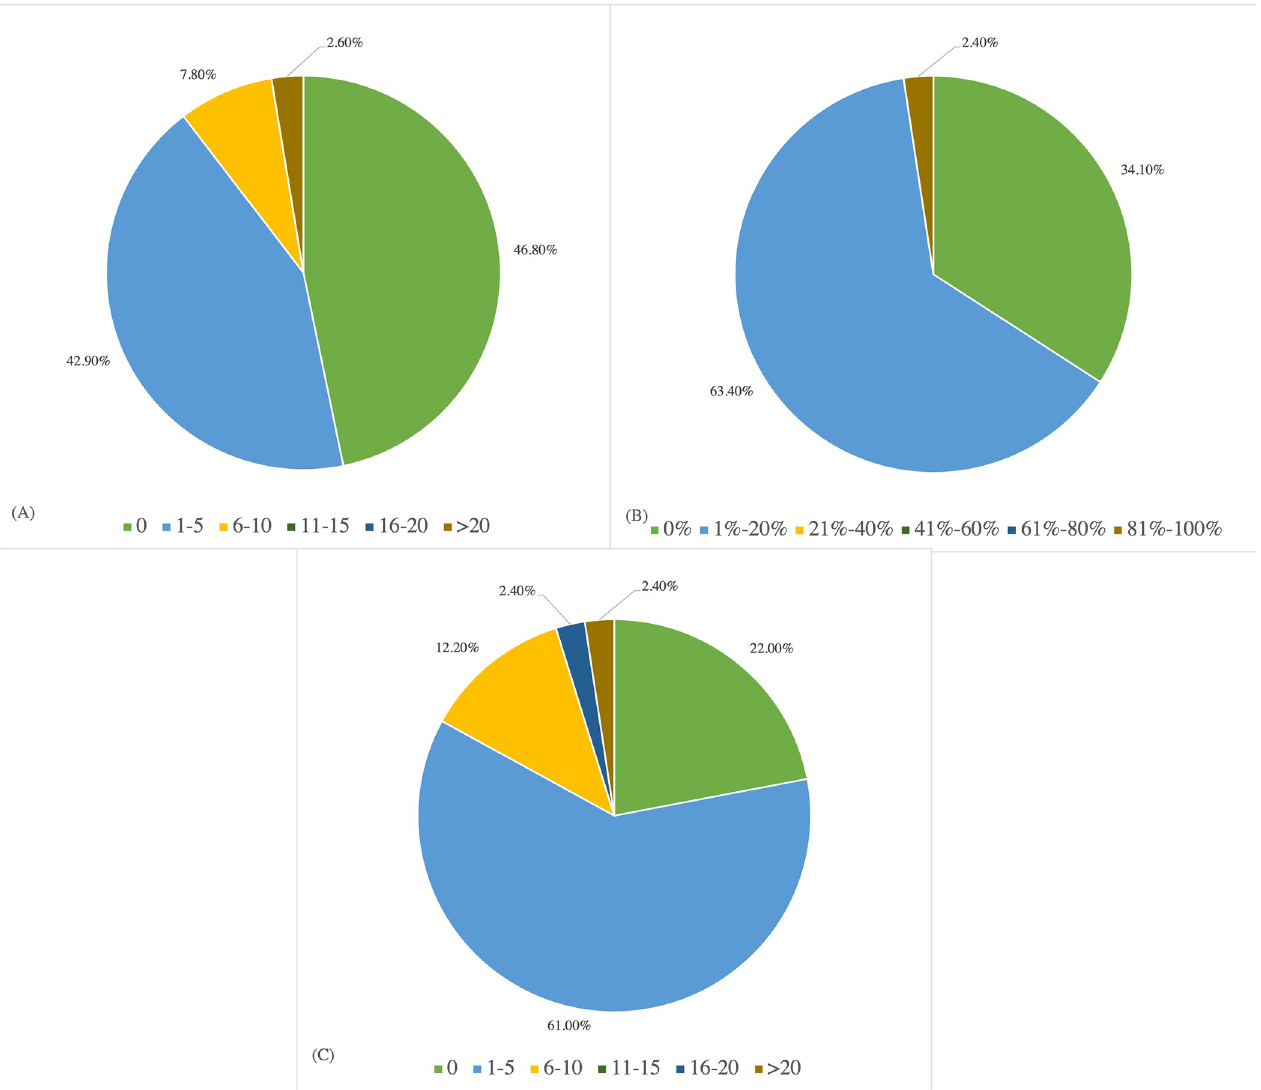
Fig 4. Distribution of Cantonese-speaking children with or suspected with childhood apraxia of speech on the respondents’ caseloads. (A) Distribution of the number of Cantonese-speaking children with or suspected with childhood apraxia of speech on the respondents’ caseloads; (B) Distribution of percentage of Cantonese speakers with or suspected with childhood apraxia of speech on the respondents’ caseloads; (C) Distribution of the number of children with or suspected with childhood apraxia of speech who were initially diagnosed or suspected by the